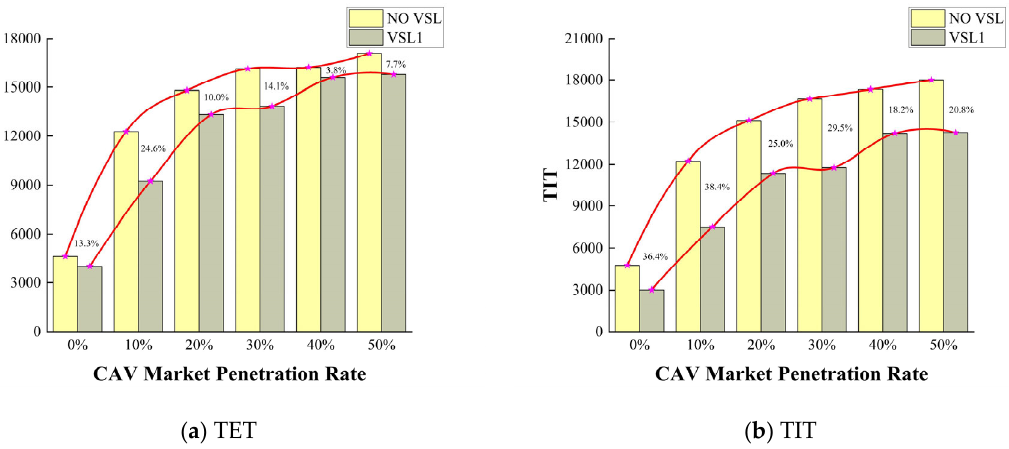
Figure 4. Results of VSL control derived from secondary collision risk reduction strategy.